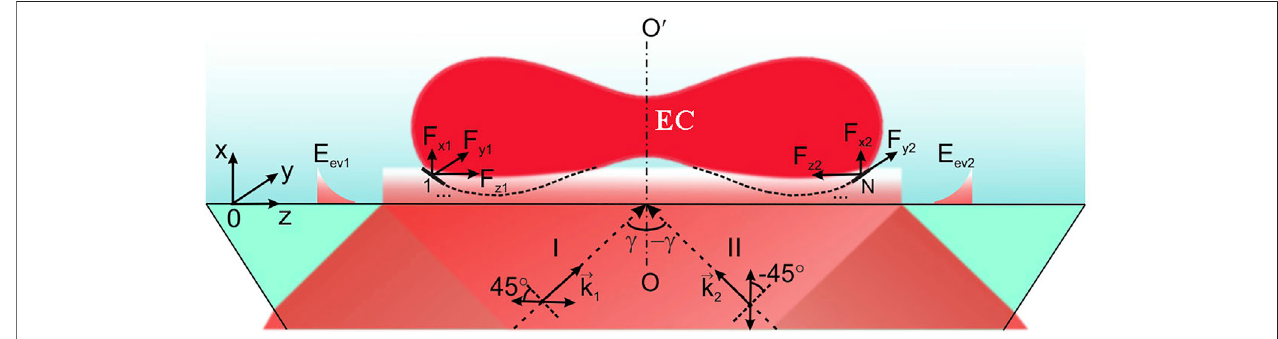
FIGURE 15 | Superposition of the opposite evanescent waves formed by the total re fl ection of two beams linearly polarized at ±45 ° with respect to the plane of incidenceandapproachingtheprismsurfaceatanangle γ > arcsin( n l / n p )where n l and n p aretherefractiveindicesoftheliquidabovetheprismandoftheprismmaterial, correspondingly. Here E ev 1 and E ev 2 denote the separate evanescent waves formed from the incident beams with the wavevectors k 1 and k 2 ; F x 1 , F x 2 , F y 1 , F y 2 , F z 1 , F z 2 are the optical-force components acting on small areas of the erythrocyte cell (EC) surface; OO ′ is the symmetry axis of the